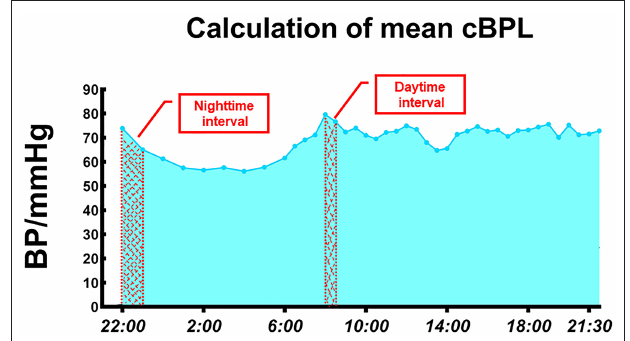
FIGURE 1 | Calculation of mean cBP load. BP, blood pressure; cBPL, cumulative blood pressure load.